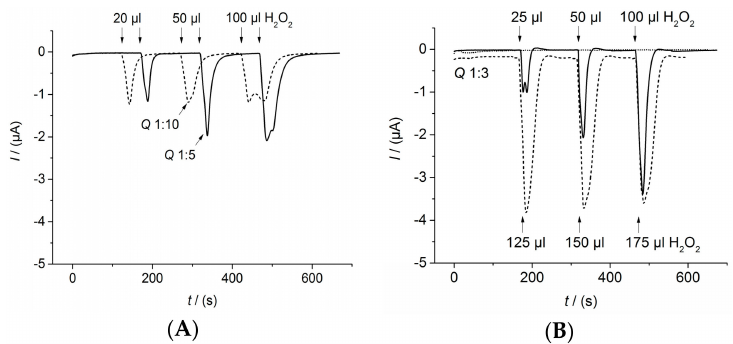
Figure A4. Determination of flow parameters. Amperometric measurements performed at 0.0 V: ( A ) total flow 1 mL/min. For Q 1:10 (dashed line), continuous flow of 1 mM hydroquinone in 0.1 M PBS pH 6.0 with 0.9 mL/min, injection flow of 1.5 mM hydrogen peroxide in 0.1 M PBS pH 6.0 with 0.1 mL/min. For Q 1:5 (solid line), continuous flow of 1 mM hydroquinone in 0.1 M PBS pH 6.0 with 0.8 mL/min, injection flow of 1.5 mM hydrogen peroxide in 0.1 M PBS pH 6.0 with 0.2 mL/min. Injection volume 20, 50, and 100 µ L; ( B ) total flow 1.2 mL/min. For Q 1:3 (dashed and solid line), continuous flow of 1 mM hydroquinone in 0.1 M PBS pH 6.0 with 0.8 mL/min, injection flow of 1.5 mM hydrogen peroxide in 0.1 M PBS pH 6.0 with 0.4 mL/min. Injection volume 25, 50, 100, 125, 150, and 175 µ L. For Q 1:3 (dotted line), continuous flow of 1 mM hydroquinone in 0.1 M PBS pH 6.0 with 0.8 mL/min, injection flow of 1 mM hydroquinone in 0.1 M PBS pH 6.0 with 0.4 mL/min and injection volume 25, 50, and 100 µ L.